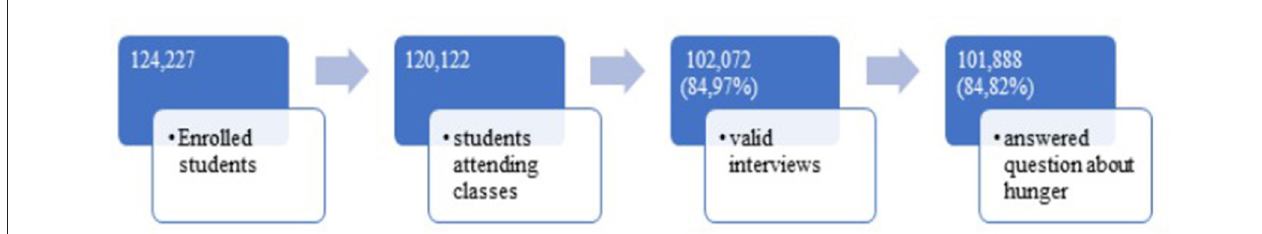
FIGURE 1 | Flowchart of students enrolment in the National Survey of school Health (PeNSE), Brazil, 2015.